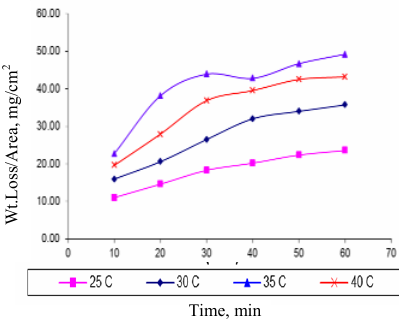
Figure 4. Effect of temperature on corrosion rate in sulphuric acid